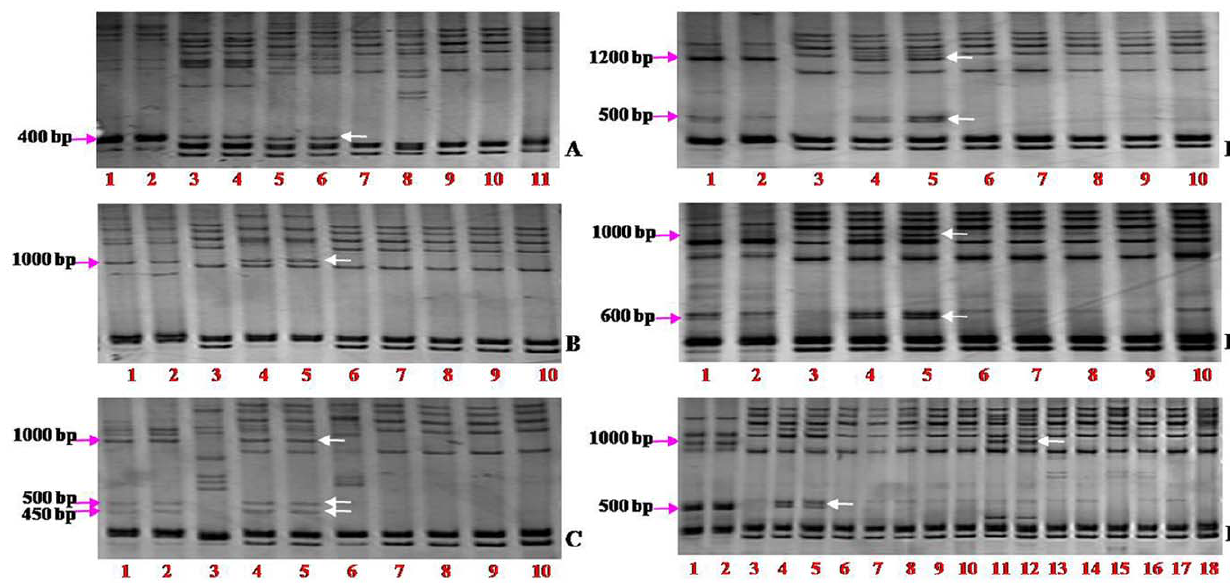
Figure 2. Conserved RPK genes identified by the STS marker STS RPK-F1/R1 from the homoeologous group-2 chromosomes of a series of wheat and Triticeae species. Arrows indicate the RPKs specific to each species. A: Barley and ‘Chinese spring’ (CS)-barley disomic chromosome addition (DA) lines. Lanes 1 and 2: Barley variety BETZES; 3 and 4: DA2H; 5 and 6: DAt’’[2H] (ditelosomic chromosome addition line); 7: DA3H; 8: DA4H; 9: DA5H; 10: DA6H; 11: DA7H. B: Rye and CS-rye DA lines. Lanes 1 and 2: Rye variety BLANCO; 3: DA1R; 4 and 5: DA2R; 6: DA3R; 7: DA4R; 8: DA5R; 9: DA6R; 10: DA7R. C. Ae. speltoides and CS- Ae. Speltoides DA lines. Lanes 1 and 2: Ae. speltoides ; 3: DA1S; 4 and 5: DA2S; 6: DA3S; 7: DA4S; 8: DA5S; 9: DA6S; 10: DA7S. D. Ae. longissima and CS- Ae. longissima DA lines. Lanes 1 and 2: Ae. longissima ; 3: DA1S l ; 4: DA2S l # 3-1; 5: DA2S l # 3-2; 6: DA3S l ; 7: DA4S l ; 8:DA5S l ; 9: DA6S l ; 10: DA7/4S l . E. Ae. geniculata and CS- Ae. geniculata DA lines. Lanes 1 and 2: Ae. geniculata ; 3: DA1M g ; 4 and 5: DA2M g ; 6: DA3M g ; 7: DA4M g ; 8: DA5M g ; 9: DA6M g ; 10: DA7M g . F: Ae. peregrina and CS- Ae. peregrina DA lines. Lanes 1 and 2: Ae. peregrina ; 3: DA1S p ; 4 and 5: DA2S p ; 6: DA3S p ; 7: DA4S p ; 8: DA5S p ; 9: DA7S p ; 10: DA1U p ; 11 and 12: DA2U p ; 13: DA3U p ; 14: DA4U p ; 15: DA5U p ; 16: DA6U p ; 17: DA7U p ; 18: CS.